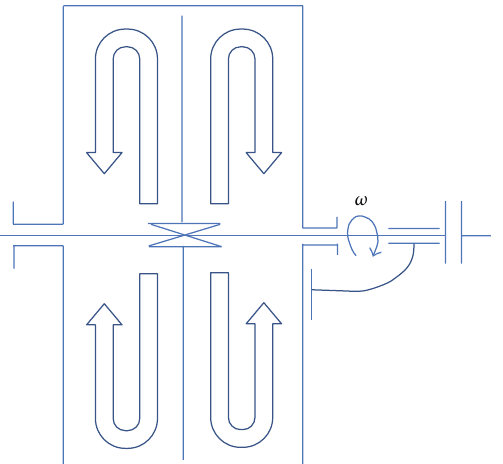
Figure 1: Simple model of disk friction